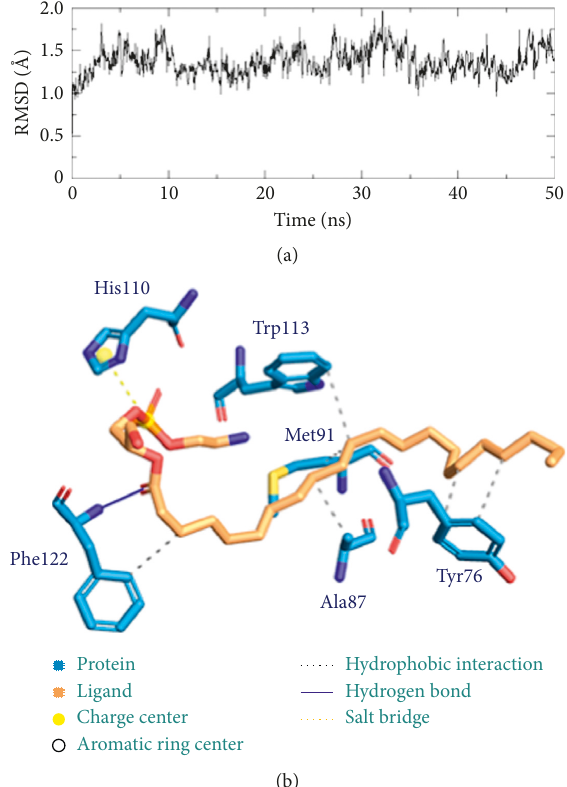
Figure 8: (a) Root mean square deviation of the OBP complex with top virtual ligand; (b) 3D map of interactions in the OBP